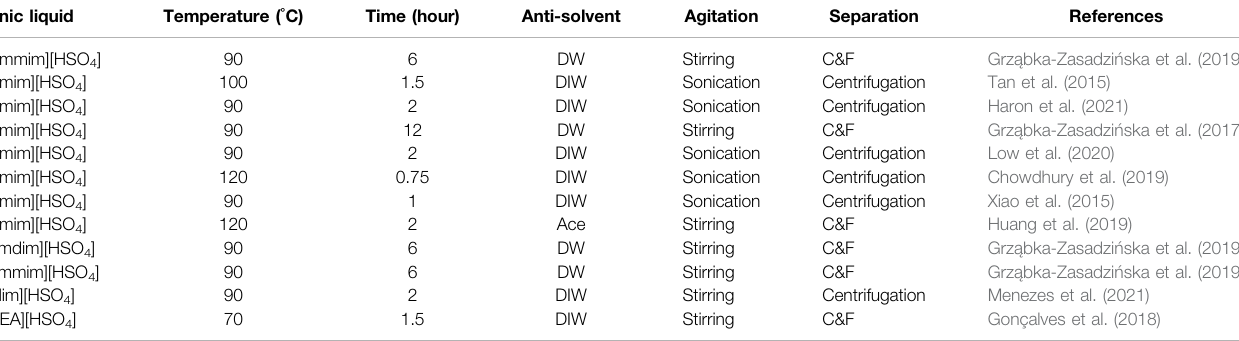
TABLE 4 | Ionic liquids, swelling temperatures, swelling times, anti-solvents, agitation, and separation processes are applied for the extraction of nanocellulose. Ionic liquid